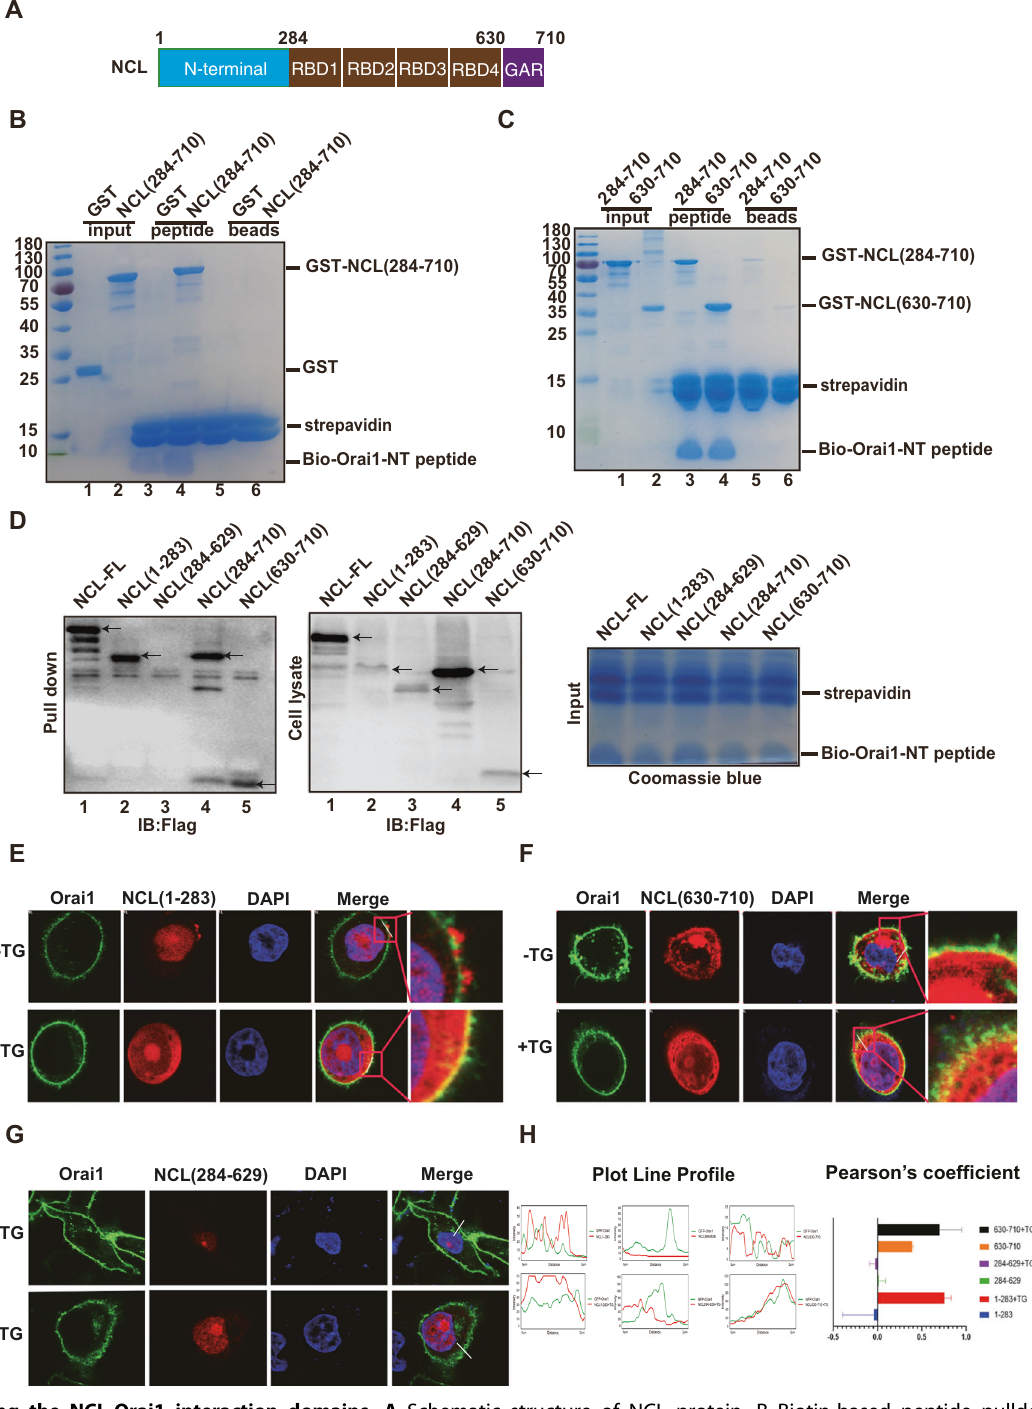
Fig. 3 Mapping the NCL-Orai1 interaction domains. A Schematic structure of NCL protein. B Biotin-based peptide pulldown assay to determine Orai1-binding domain of NCL. Puri fi ed GST and GST-NCL (284 – 710) proteins were incubated with the immobilized Orai1-NT peptides, then the precipitated samples were analyzed by SDS-PAGE. C Biotin-Orai1 peptide pulldown assay with different fragments of GST- NCL. D As in B , but with the MCF-7 cell lysate transfected with different NCL-Flag plasmids. The precipitated samples and cell lysates were detected by western blotting and bound peptides were analyzed by Coomassie staining. E Co-localization of GFP-Orai1 (green) with NCL (1 – 283)-Flag (red). MCF-7 cells co-transfected with GFP-Orai1 and NCL (1 – 283)-Flag plasmids were treated with or without TG. The cellular co- localization of Orai1 and NCL was detected by confocal microscopy. The boxed area was shown at high magni fi cation in the panels on the right. F As in E , but co-localization of GFP-Orai1 with NCL (630 – 710)-Flag was assayed. G As in E , but co-localization of GFP-Orai1 with NCL (284 – 629)-Flag was assayed. H Quanti fi cation of colocalization between the fl uorescent channels of NCL-Flag fragments and